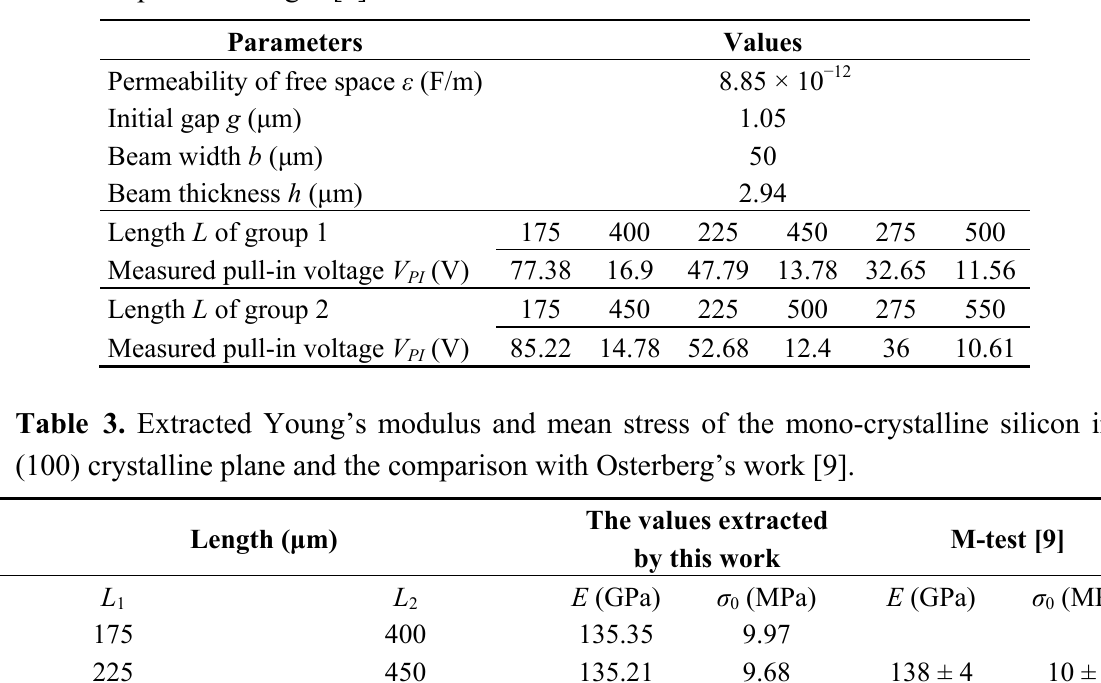
Table 2. Geometrical parameters of the mono-crystalline silicon beam samples and the measured pull-in voltages [9].